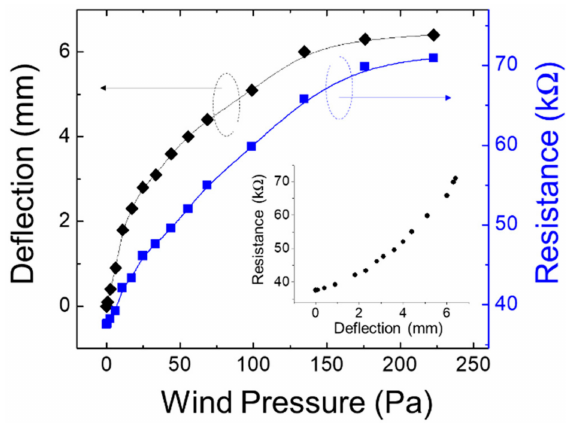
Figure 6. Deflection of the suspended structure and resistance recorded by the single sensor for di ff erent wind pressures.